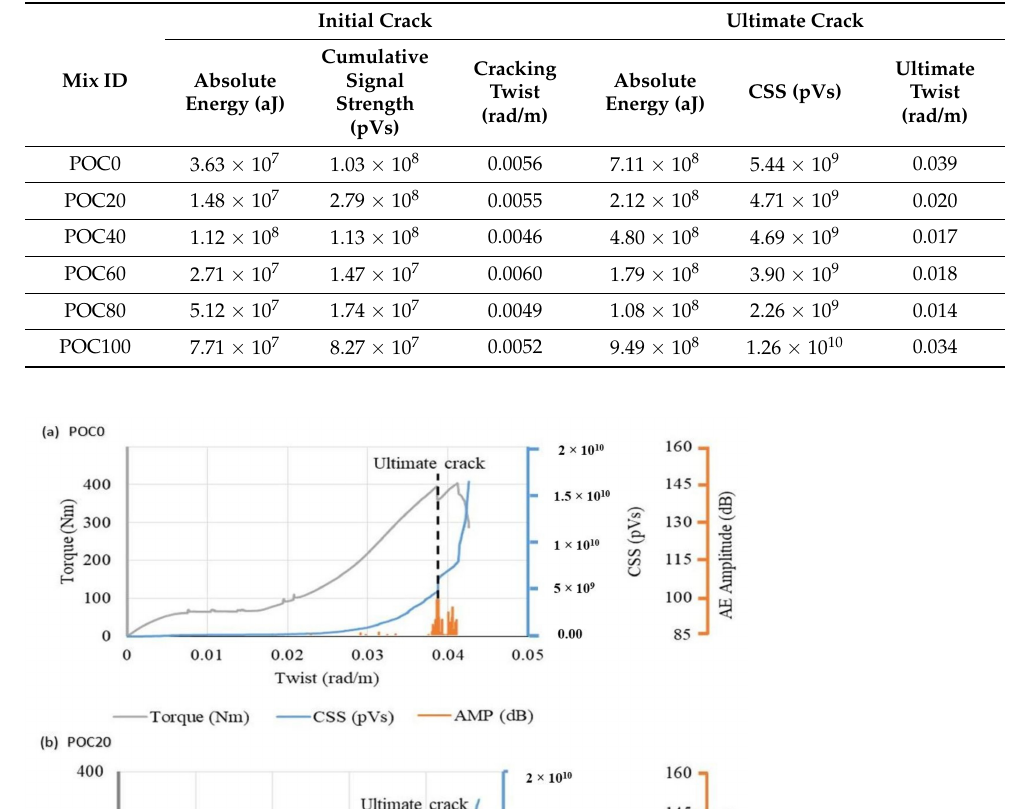
Table 4. Initial and ultimate cracks of normal weight concrete and palm oil clinker concrete.